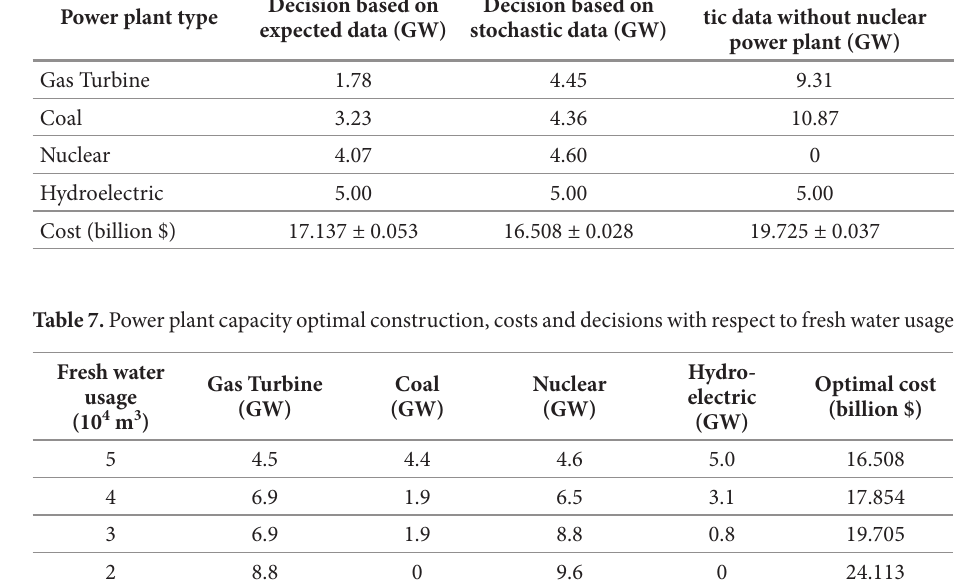
Table 6. Power plant capacity optimal construction decisions Power plant